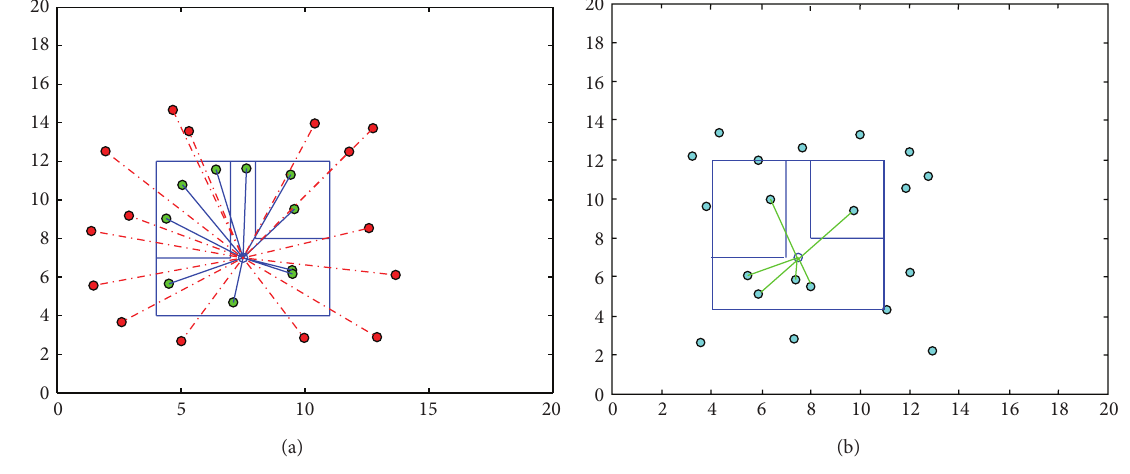
Figure 5: (a) Training and (b) testing of the femtocell device.